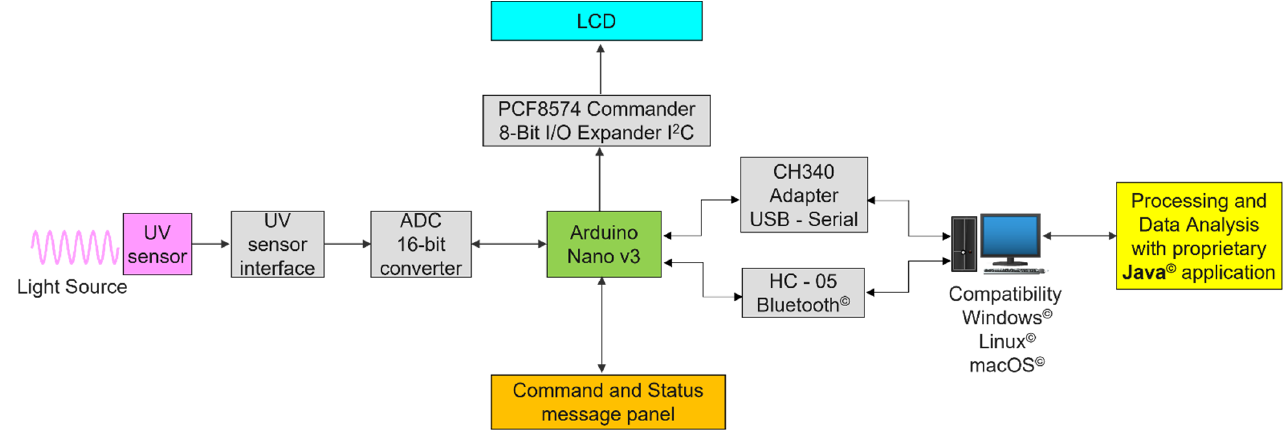
Figure 1. Block diagram of the device.